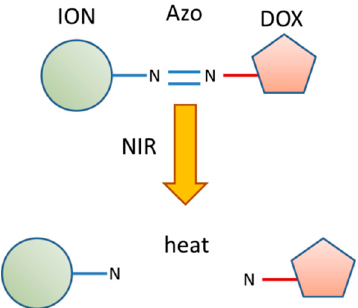
Figure 9. Schema of the breakage of IONs–4,4-azobis (4-cyanovaleric acid) (azo)–DOX after irradiation with NIR laser. with NIR